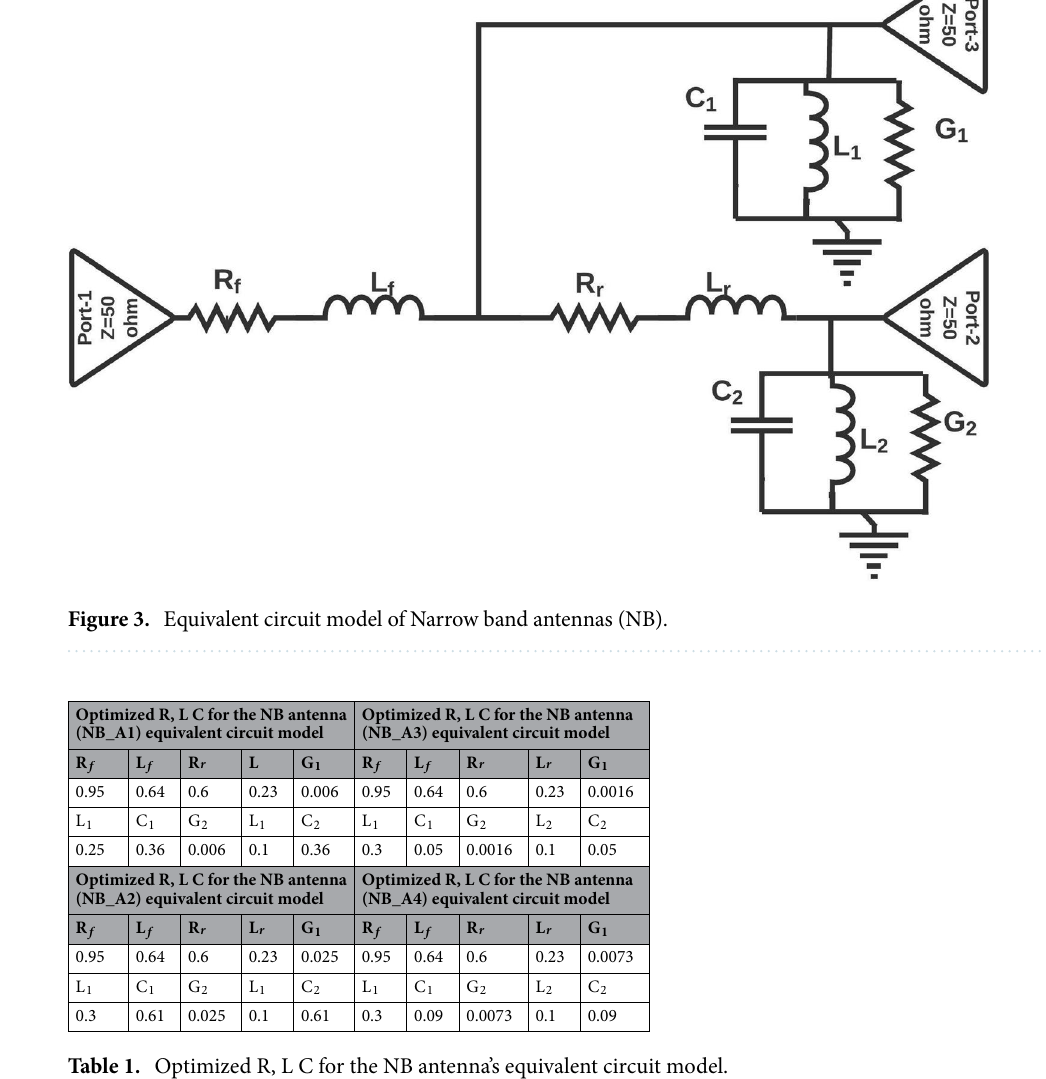
Table 1. Optimized R, L C for the NB antenna’s equivalent circuit